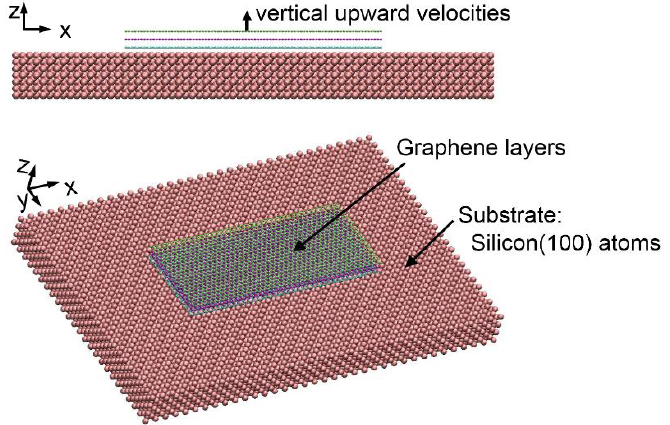
Figure 1. Molecular dynamics (MD) model of three-layer graphene on an Si substrate (front view and oblique view). Green atoms represent the topmost layer of graphene, violet atoms represent the second layer of graphene, blue atoms represent the bottom layer of graphene; the silicon surface is an Si (100) crystal plane.